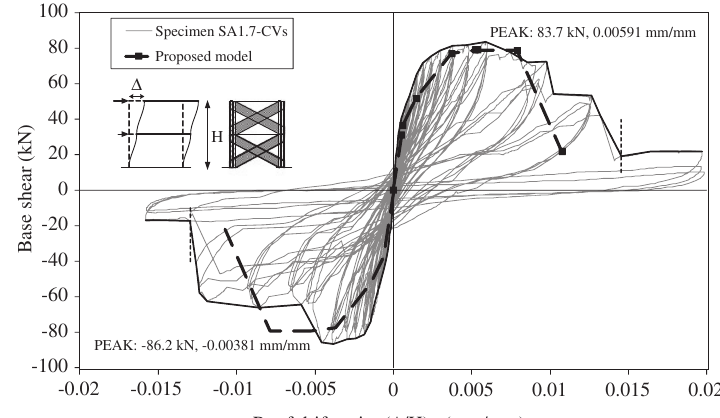
Figure 12 Response of specimen